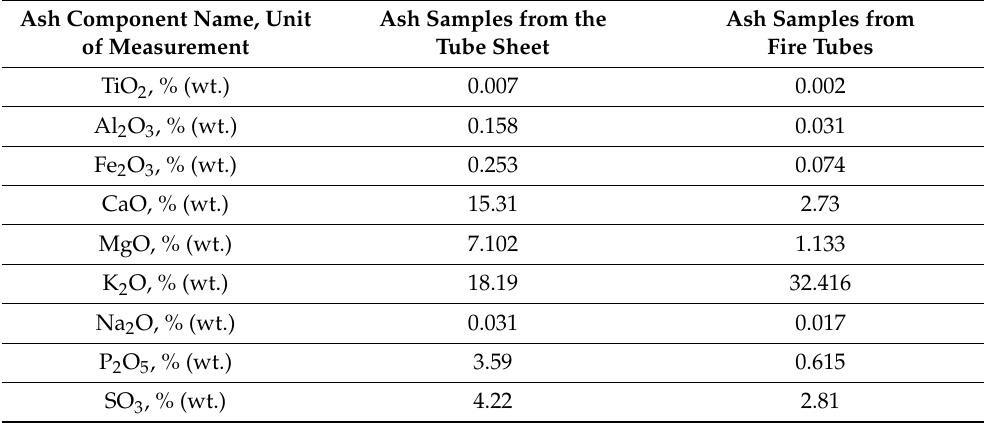
Table 3. Chemical composition (on a dry basis) of ash deposits on the tube grate and on the flue tubes of a boiler with a fluidized bed furnace of quartz sand when pellets from sunflower husks are burned in it. Ash Component Name, Unit Ash Samples from the Ash Samples of Measurement Tube Sheet